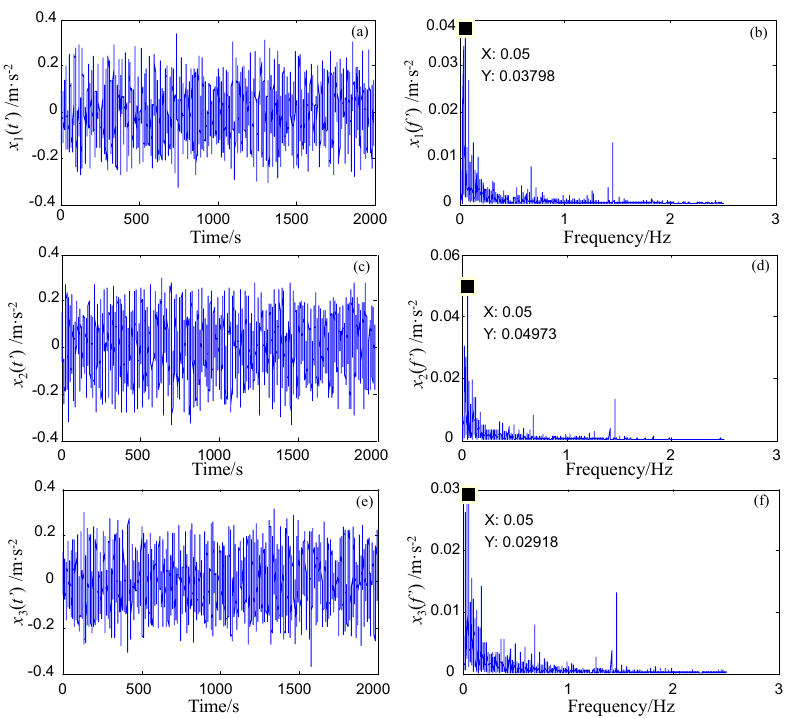
Figure 11. Fault detection of bearing outer ring based on FERSR. ( a , b ) are time-domain waveform and frequency spectrum of the detection results of the first harmonic. ( c , d ) are that of the second harmonic. ( e , f ) are that of the third harmonic.